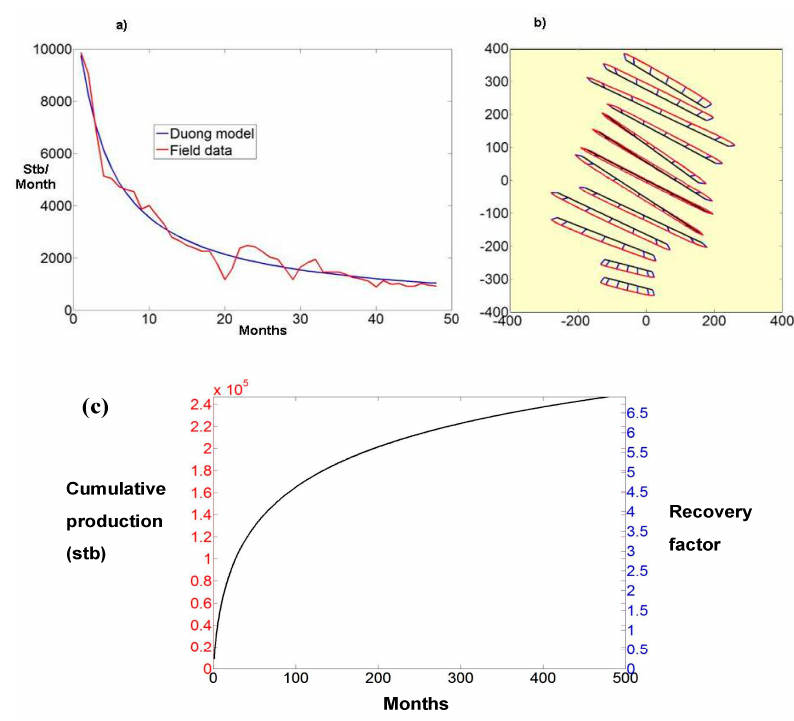
Figure 10. ( a ) History matching monthly production (bbls/month, red curve) for 50 months with Duong decline curve (blue curve). ( b ) Drained area next to the main hydraulic fractures after 480 months (40 years). ( c ) Cumulative production (in bbls; left axis) and recovery factor (in %; right axis) over time (in months, horizontal